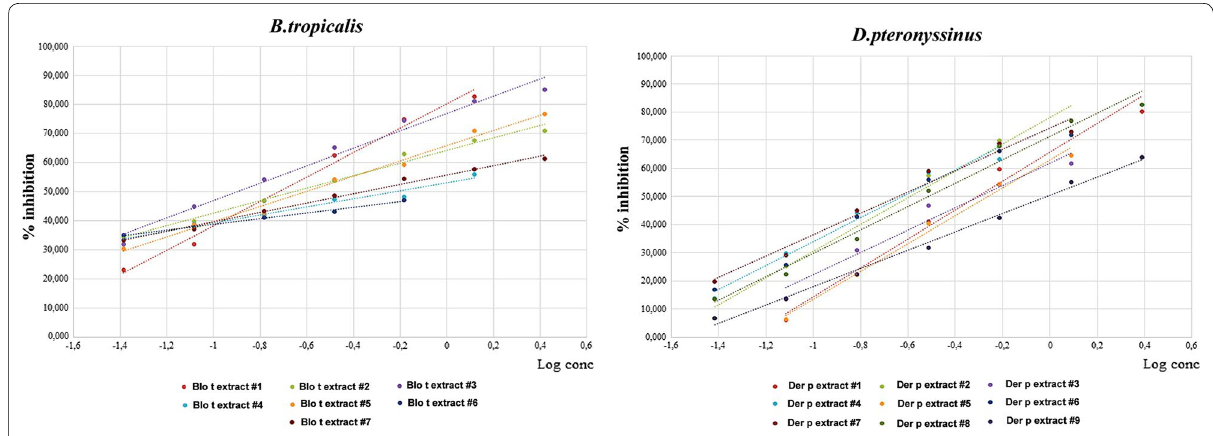
Fig. 3 CAP inhibition of commercial extracts ( B. tropicalis and D. pteronyssinus ) from manufacturers 1 to 9